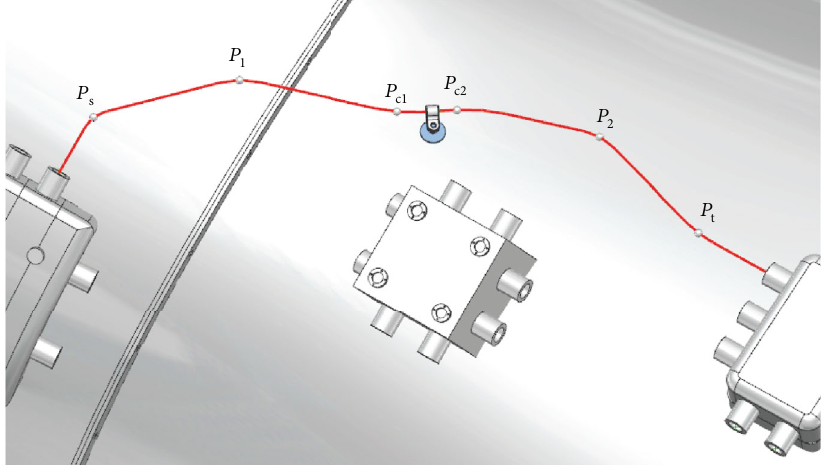
Figure 4: Clamp-based pipe path mode.